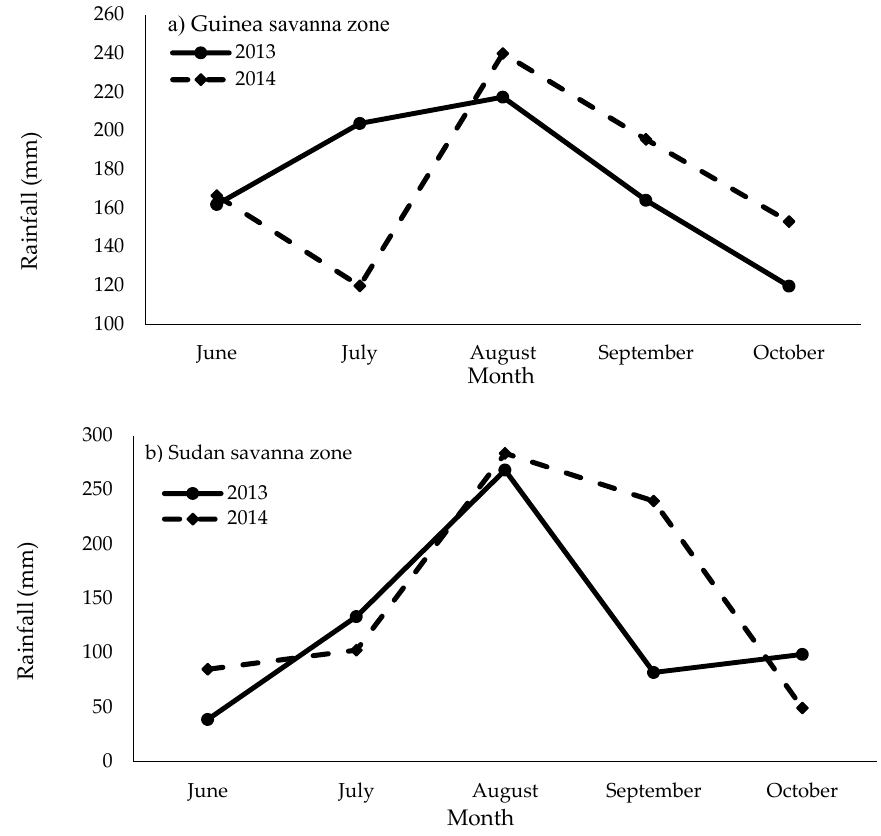
Figure 1. Rainfall pattern in Guinea and Sudan savanna ecology during 2013 and 2014 cropping